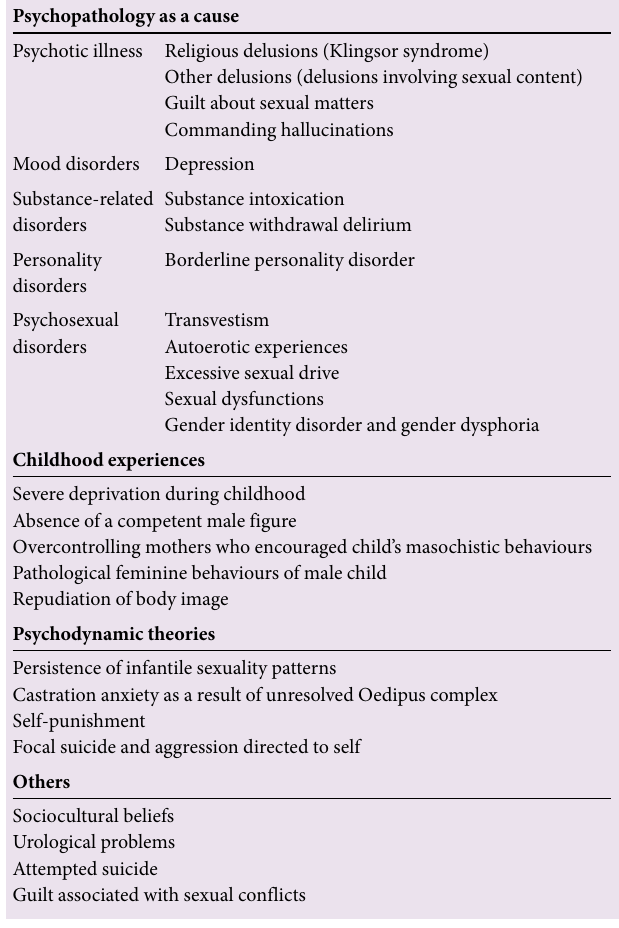
Table 1. Aetiological theories of genital self-mutilation